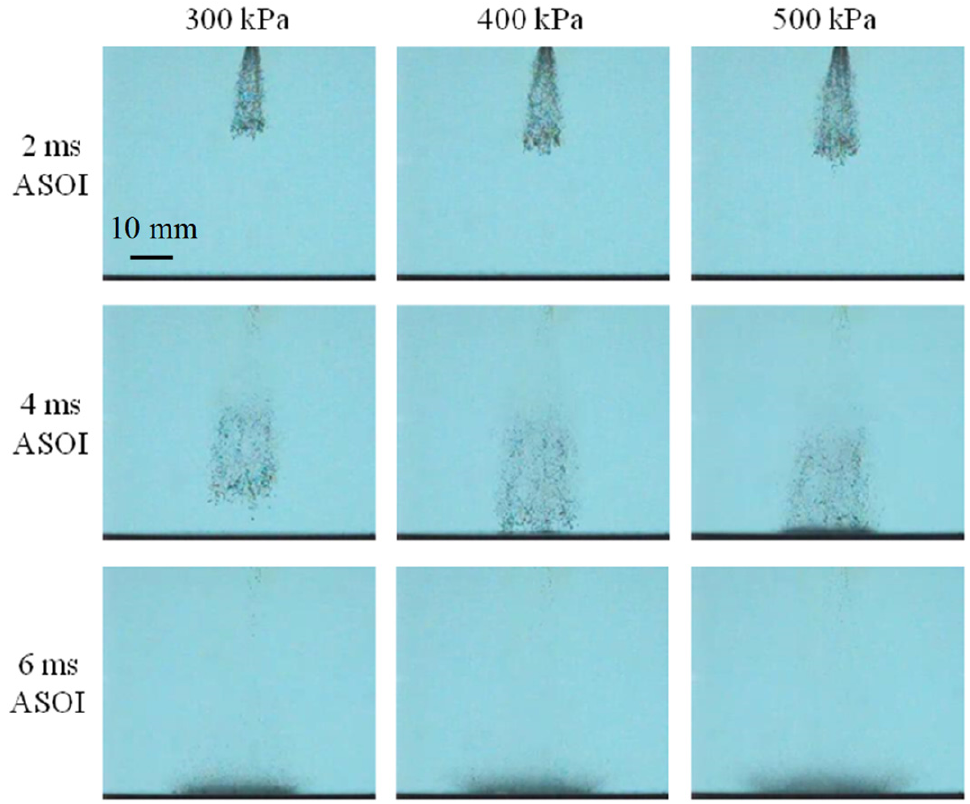
Figure 10. The spray morphology under different P inj (300 kPa to 500